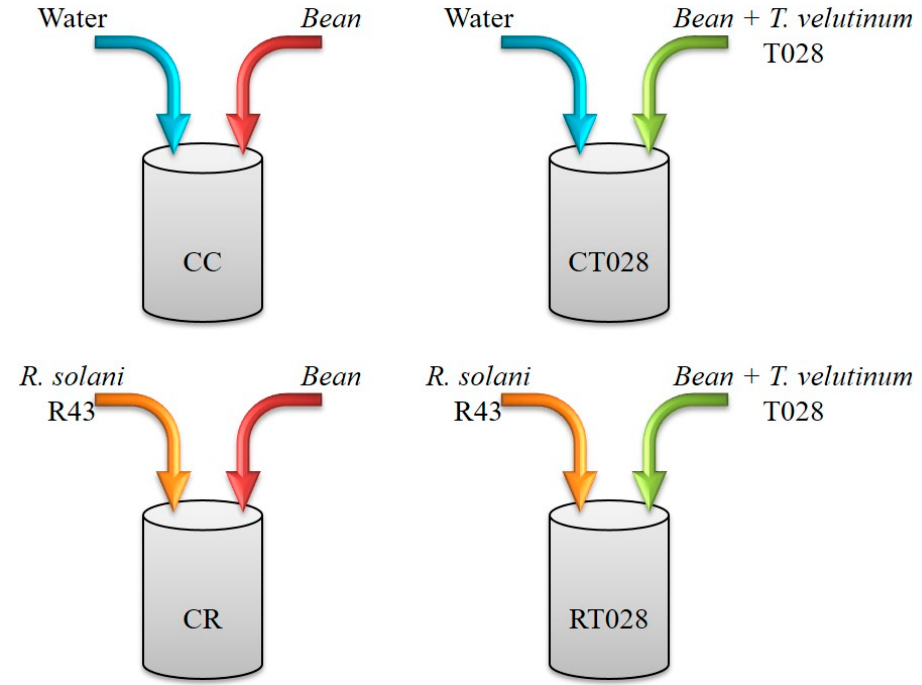
Figure 1. Scheme of the treatments performed in this work: CC, water control plants without fungal treatments; CT028, seeds coated with T. velutinum grown in uninfected soil; CR, untreated seed grown in R. solani (R43)-infected soil; and RT028, seeds coated with T. velutinum (T028) grown in R. solani (R43)-infected soil.